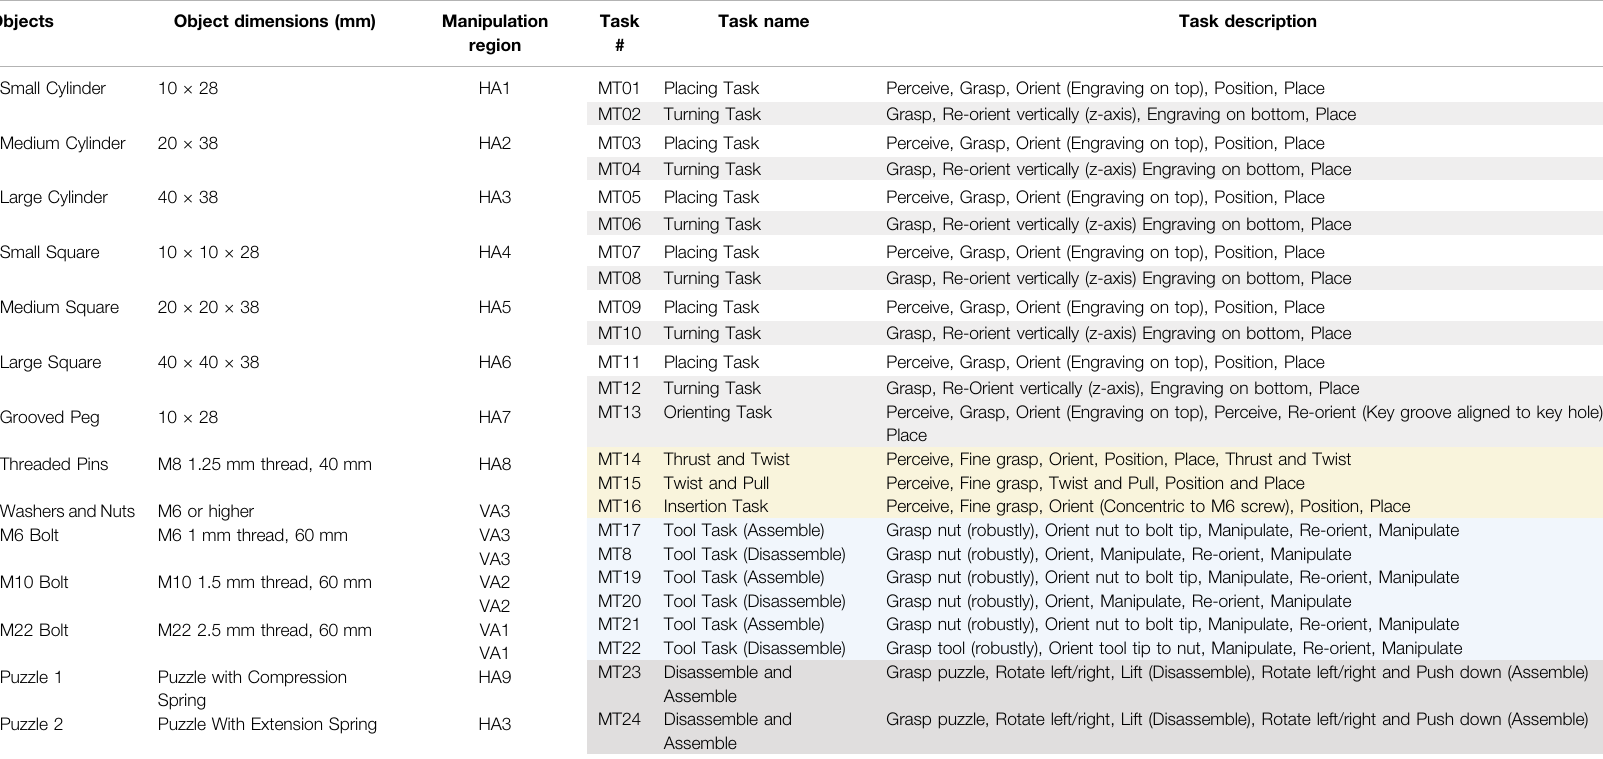
TABLE 1 | Dexterity test board components, regions, and task description grouped according to the fi ve task categories and annotated with different colours. Pick and